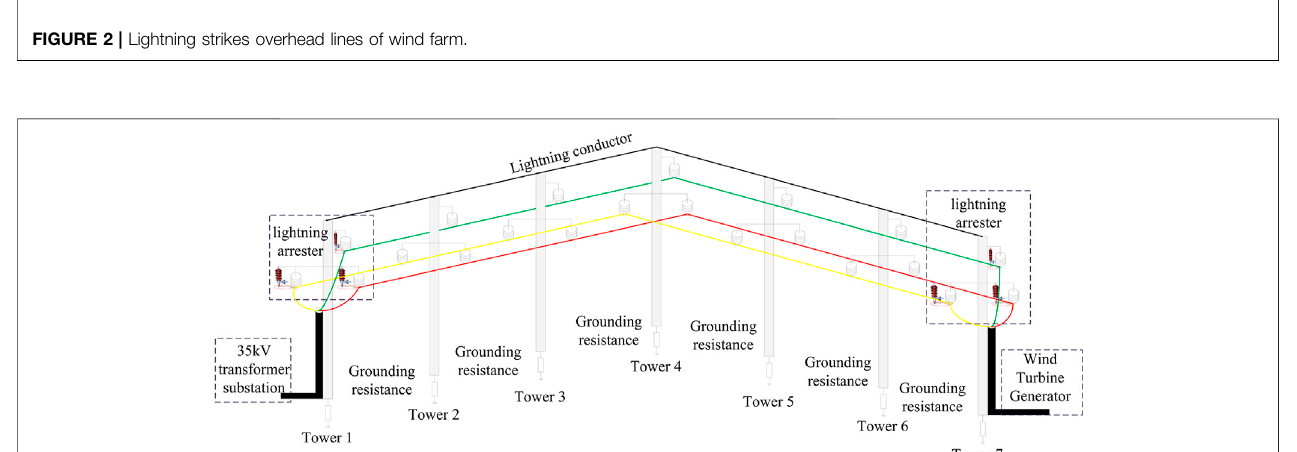
FIGURE 3 | Schematic diagram of distribution line from substation to